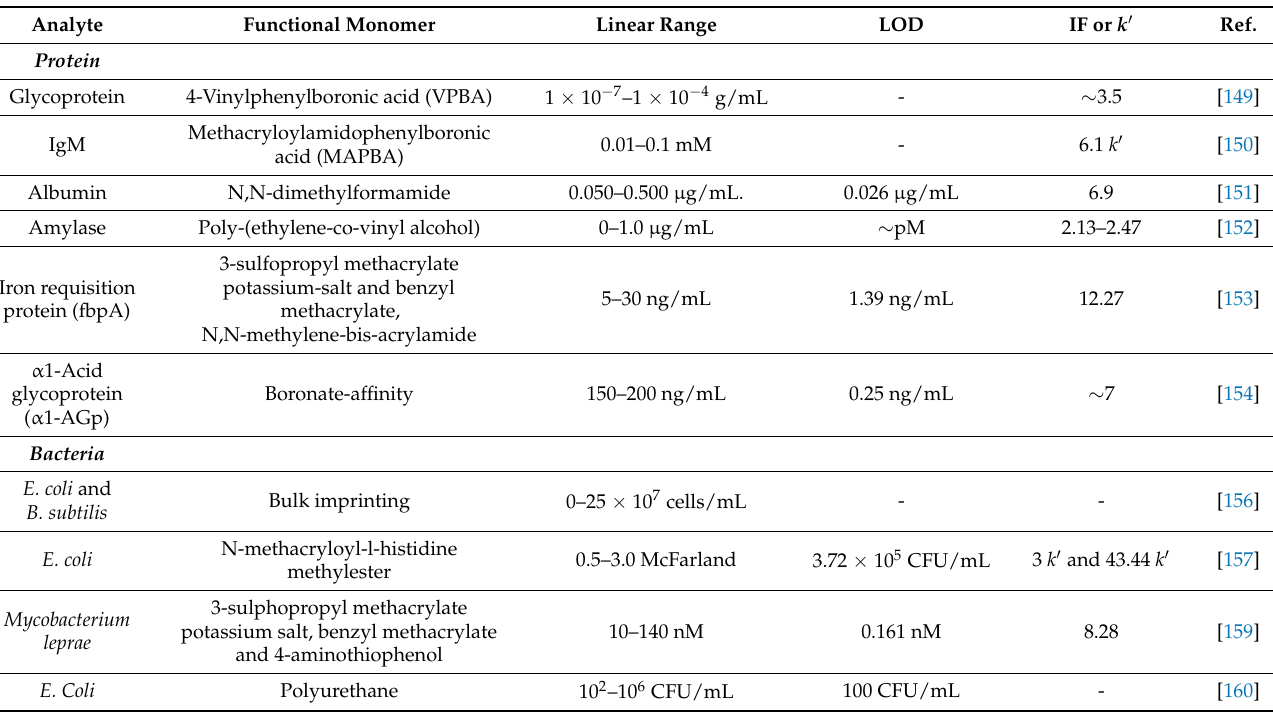
Table 1. QCM biosensors based on molecular imprinting techniques for various disease- related